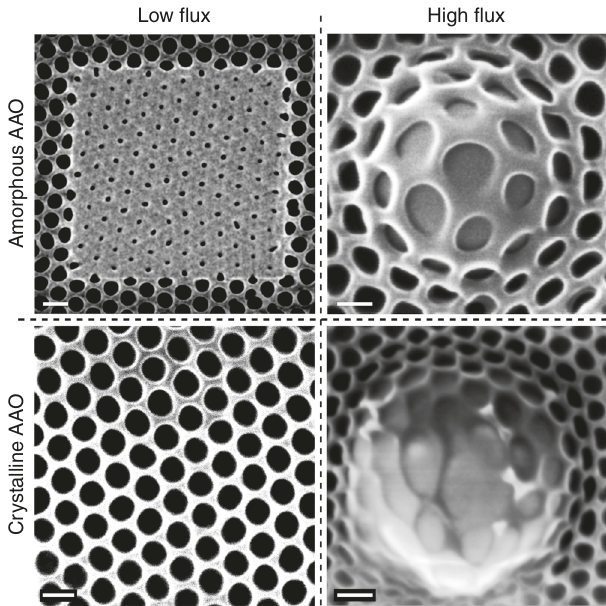
Fig. 2 The role of ion fl ux and chemical bonds. The key experimental observations in amorphous and crystalline AAO under low- fl ux and high- fl ux conditions are summarized (materials: am-AAO vs c-AAO; ion beams: 'low- fl ux' vs 'high- fl ux'). Two signi fi cantly different fl ux-dependent regimes are observed: within the 'low- fl ux' regime pores in am-AAO shrink to smaller pores, while c-AAO shows remarkable resistance to irradiation; within the 'high- fl ux' regime (and at high fl uence where the substrate swelling occurs) pores in am-AAO do not shrink anymore; however the thin fi lm shows surprising superplastic behavior, in contrast with c-AAO, which exhibits bond breaking and irregular deformation.(The fl ux of F < 10 and F > 100 ions nm − 2 s − 1 , referred herein as 'low- fl ux' and 'high- fl ux'regimes, respectively). The scale bar is 100